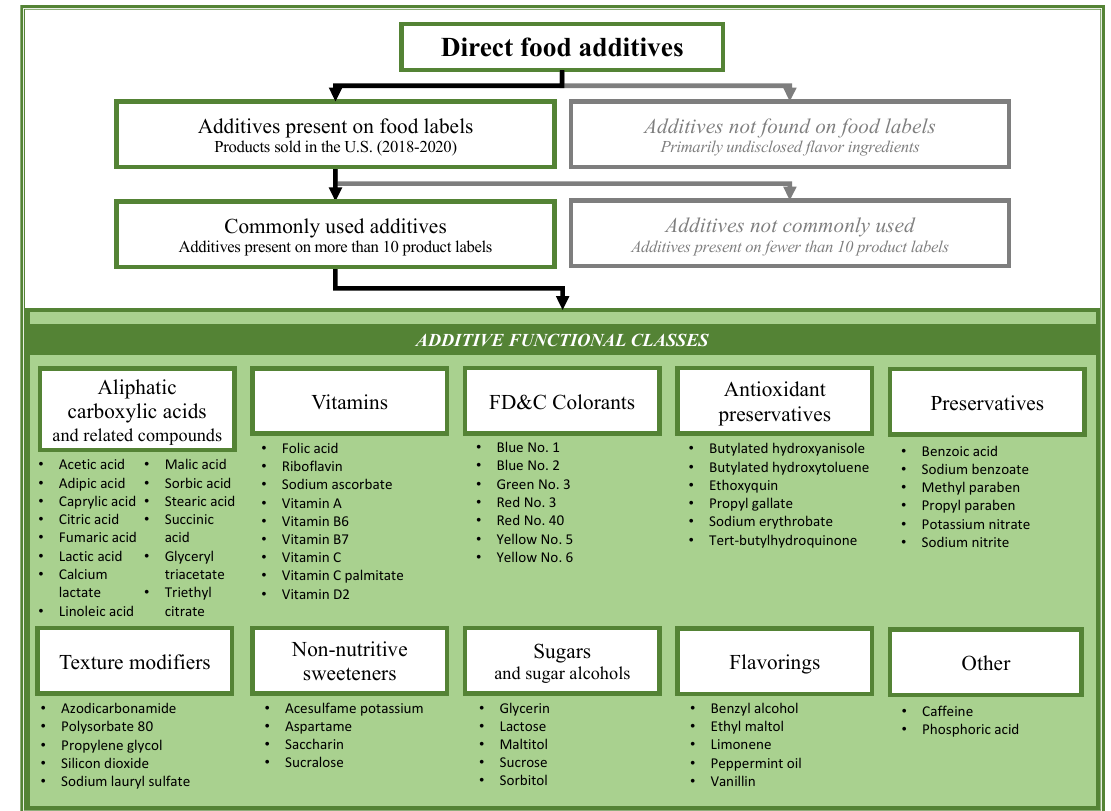
Figure 1. Flow diagram for identification of direct additives included in this study. Initial group of direct food additives analyzed in this study was defined in a publication by Karmaus et al. [33].